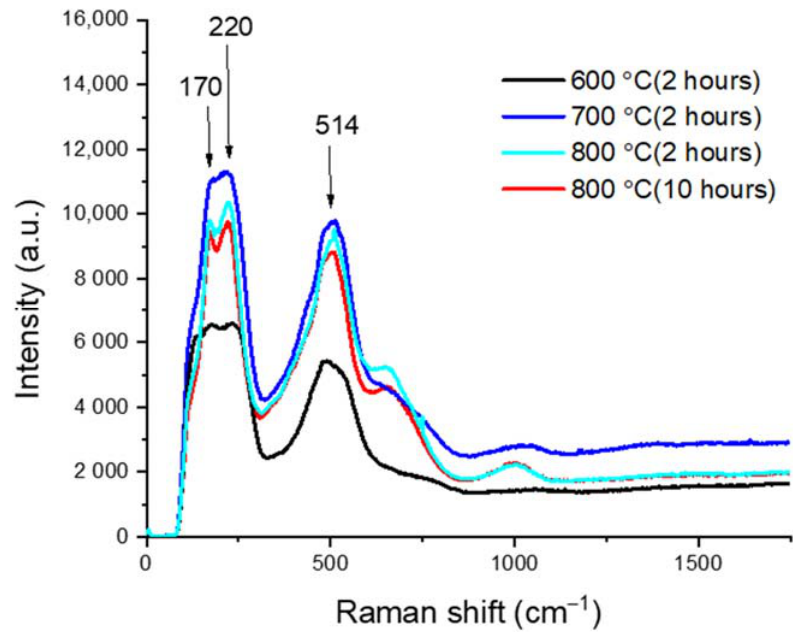
Figure 3. Raman spectra of Zircaloy-4 nitrided at 600, 700, and 800 °C.